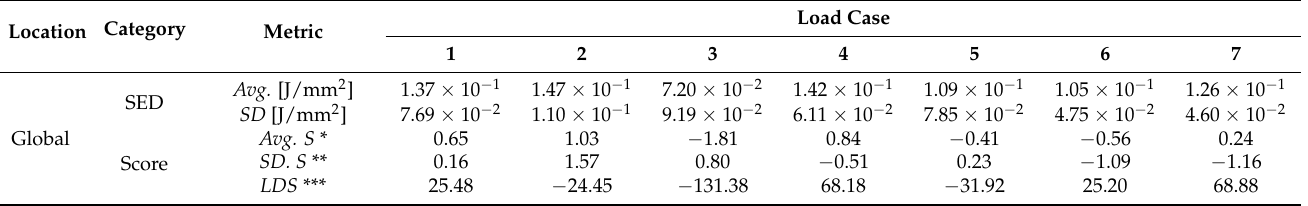
Table 2. Results of the statistical analysis for strain energy density and scores for global model for each load